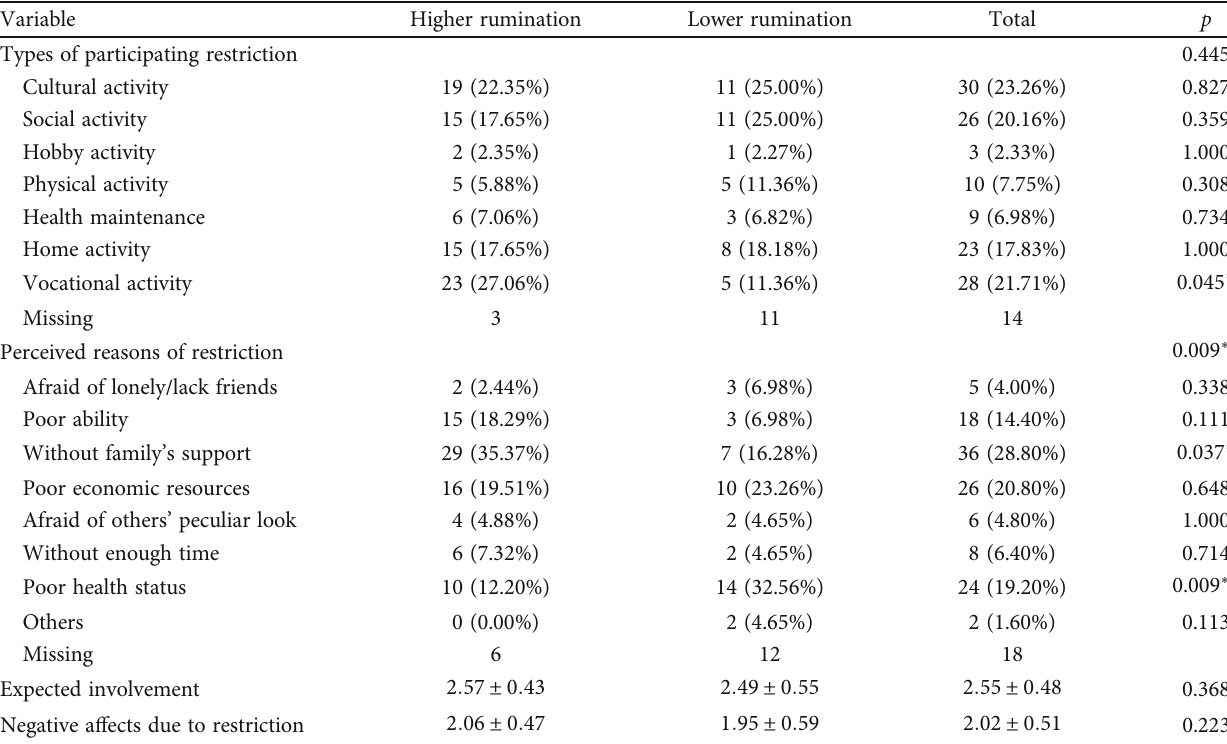
Table 3: The di ff erences in the pro fi les of participation restriction between participants with higher vs. lower rumination tendency.